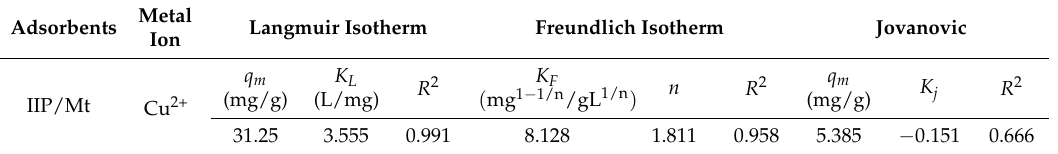
Table 3. Adsorption equilibrium constants for Langmuir and Freundlich and Jovanovic isotherms. Metal Adsorbents